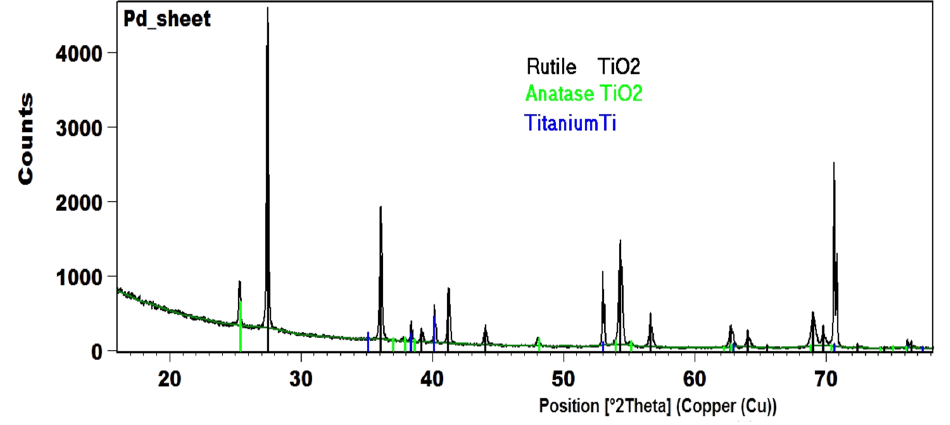
Figure 4. XRD patterns of TiO 2 /Ti after PEO processes:  TiO 2 rutile;  TiO 2 anatase,  Ti.